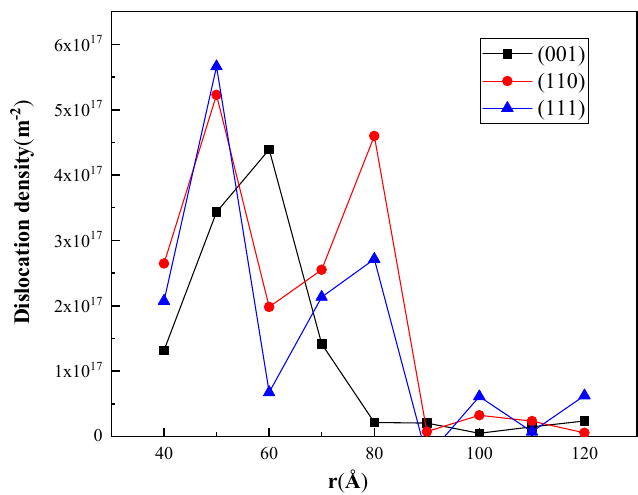
Figure 15. Local dislocation densities in samples indented on different planes after unloading.